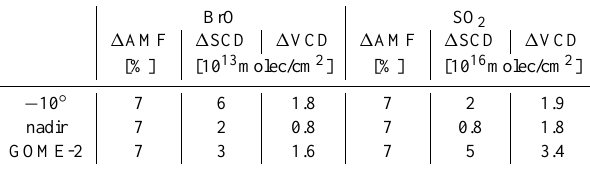
Table 2. Error estimates for BrO and SO 2 vertical column densities for an individual CARIBIC spectrum (-10 ◦ and nadir) and GOME-2 during the observation of the plume (Sect. 4.1).